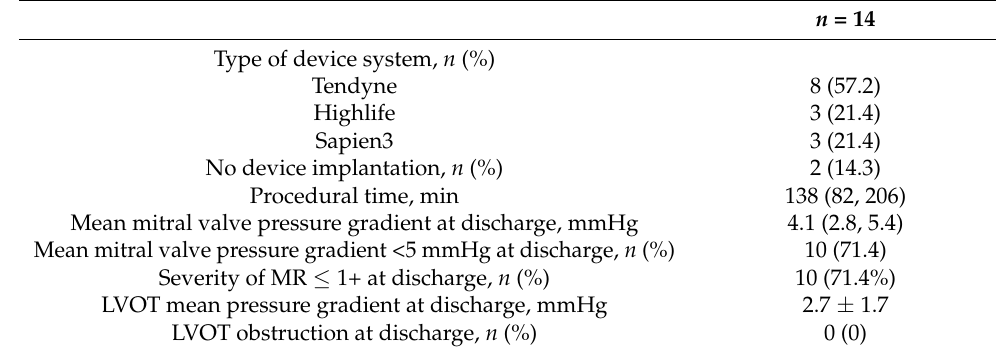
Table 3. Procedural characteristics of